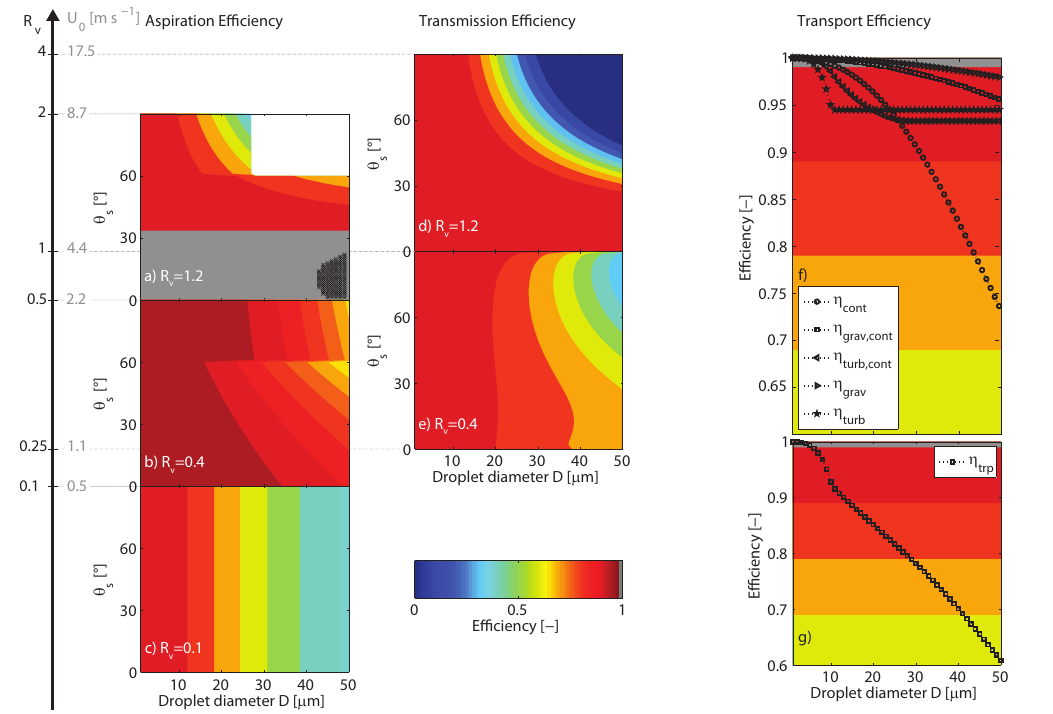
Fig. 7. Efficiencies for the different particle loss mechanisms for the FM-100 calculated under standard atmospheric conditions ( p =1013mbar, T =0 ◦ C) using the equations presented in Appendix A for sampling angles θ s ∈ [0 ◦ , 90 ◦ ]. For gray colors the efficiency is 1, decreasing from 0.99 (red) to 0 (blue), shaded area indicates efficiency > 1.05. White indicates that the efficiencies could not be calcu- lated, as the input variables were not inside the range of validity. For each velocity range of η asp , one representative panel (values in brackets) is shown: (a) moving air ( U 0 =5.24ms − 1 which corresponds to a velocity ratio R v = U 0 / U =1.2), (b) slow moving air ( U 0 =1.7ms − 1 which is equal to R v =0.4) and (c) calm air ( U 0 =0.43ms − 1 which corresponds to a velocity ratio R v of 0.1). For η trm one panel for sub-kinetical sampling (d) and one for super-kinetical sampling (e) is shown. The positioning of the panels (a) to (e) versus the R v -axis on the left rep- resents the range of the different velocity ranges for η asp and η trm . The different mechanisms contributing ( η cont , η grav,cont , η turb , cont , η grav and η turb ) to transport efficiency η tsp are shown individually in (f) and cumulative in (g) .